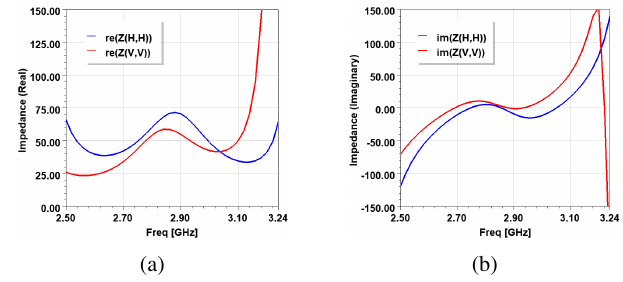
FIGURE 4: (a) Real and (b) Imaginary Impedance plots of single element